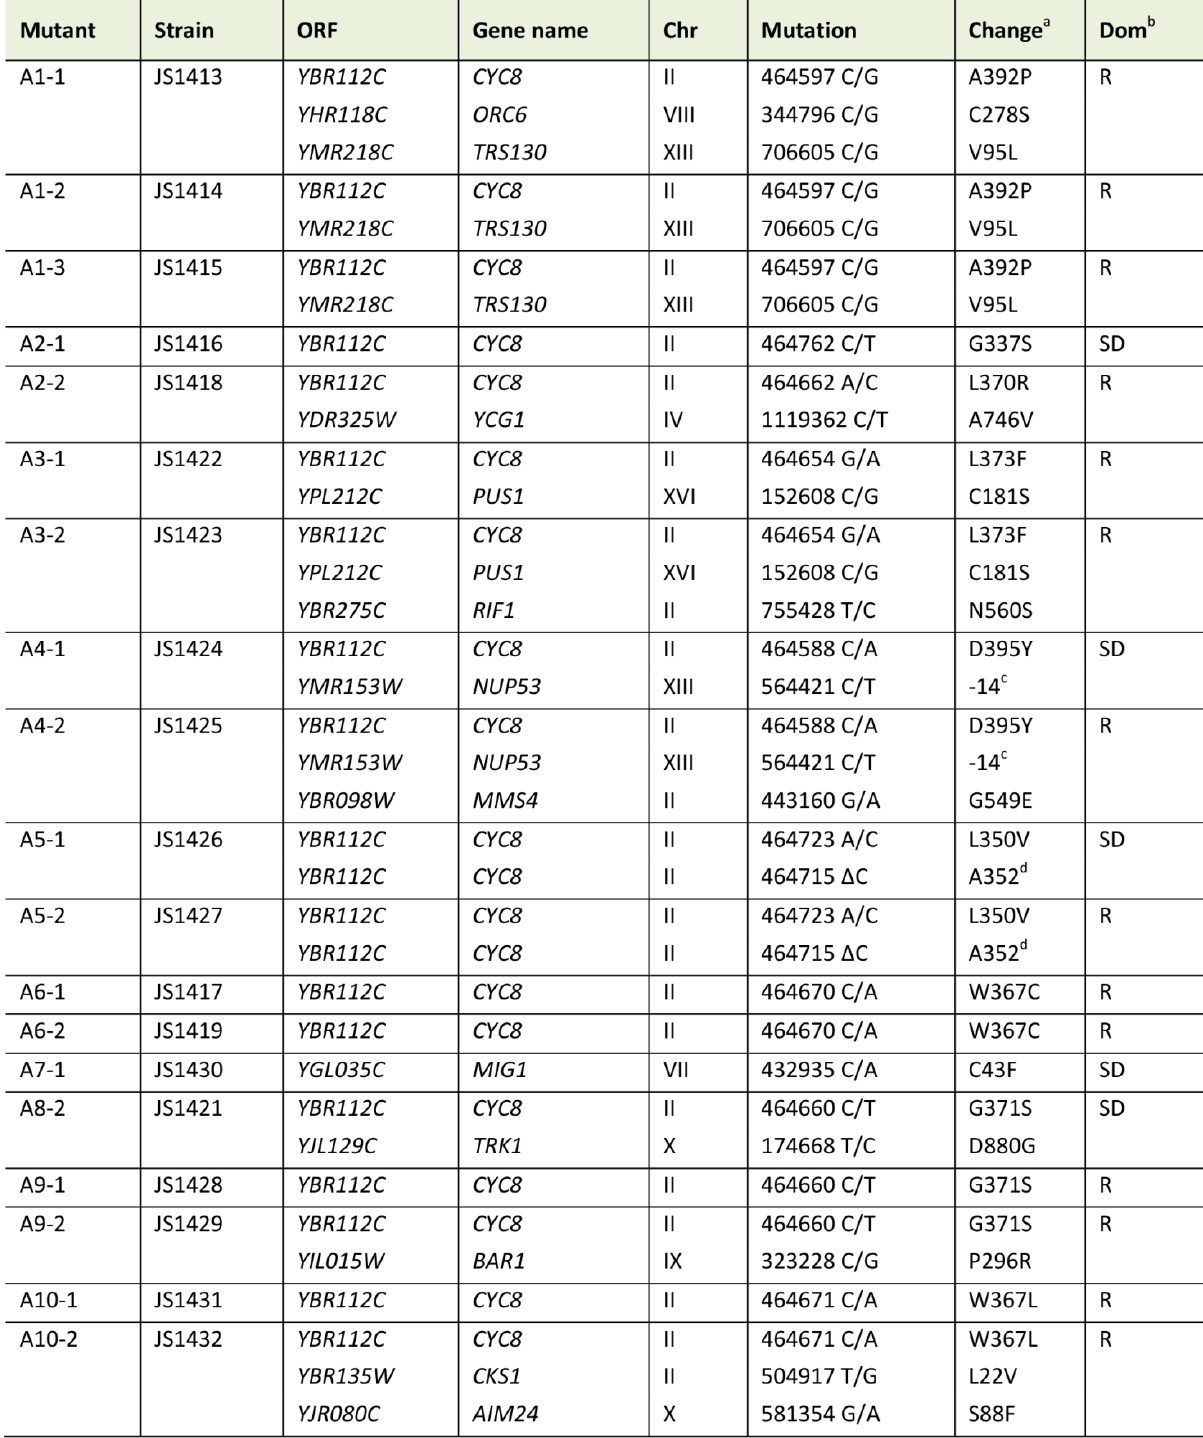
Table 1. Mutations identified from snf1 ∆ bypass suppressor CLS